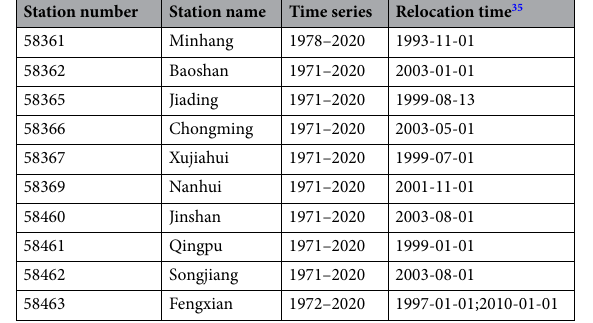
Table 1. Stations